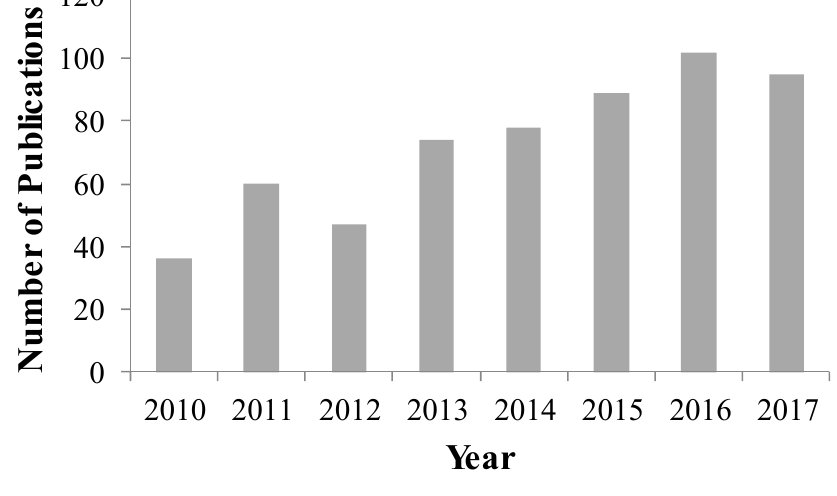
Figure 3. The number of published journal articles from 2010–2017 which reported the preparation of drug nanoparticles and drug nanocomposites. Source: Scopus database, key words used: “drug nanoparticles” or “drug nanocomposites” or “drug + drying + nanocrystals” or “drug + drying + nanosuspensions”.